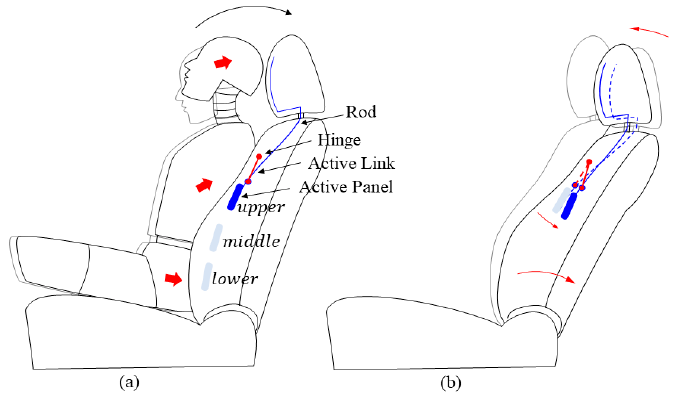
Figure 2. Schematic diagram of active headrest: ( a ) components of the active headrest; ( b ) conceptual diagram of active headrest operation.